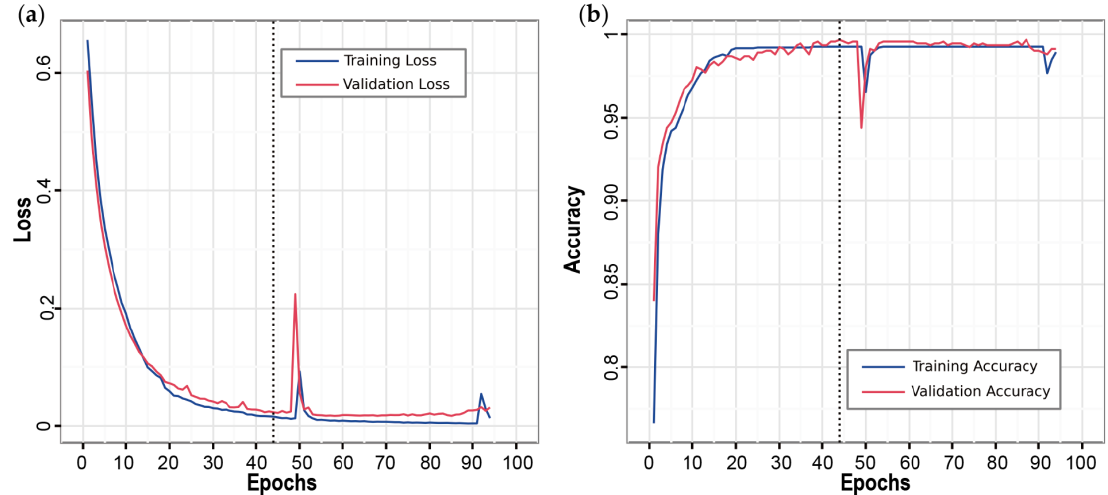
Figure 12. The training process of the PCNN showing ( a ) the loss; and ( b ) the accuracy. The dashed line indicates the epochs of early stopping.